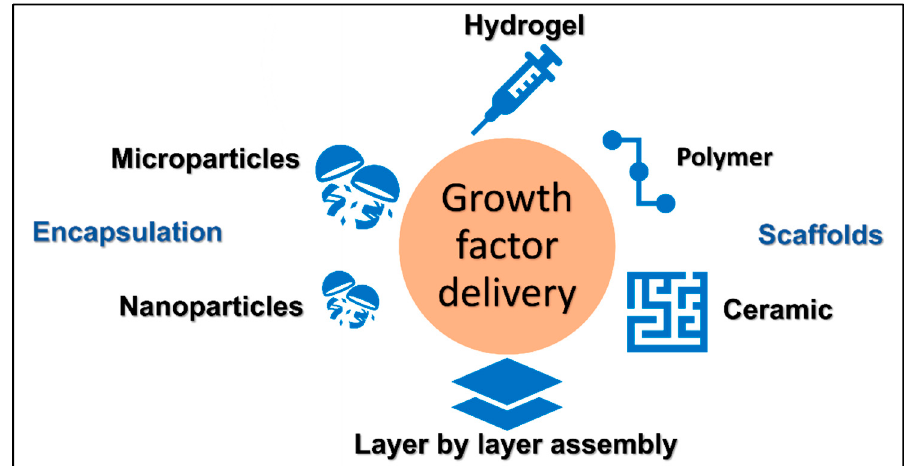
Figure 1. Methods for the delivery of growth factors. Table 2. Bioengineering methods of growth factor delivery, examples, advantages, and disad- vantages.